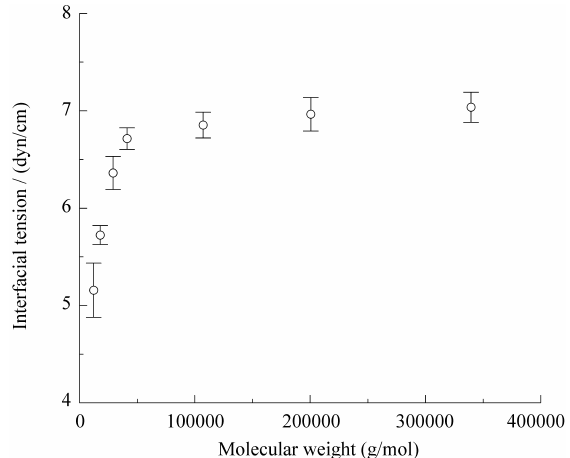
Figure 7b. Drop of PS (200,000 g/mol) in HDPE (t = 20 min) at 202 °C.